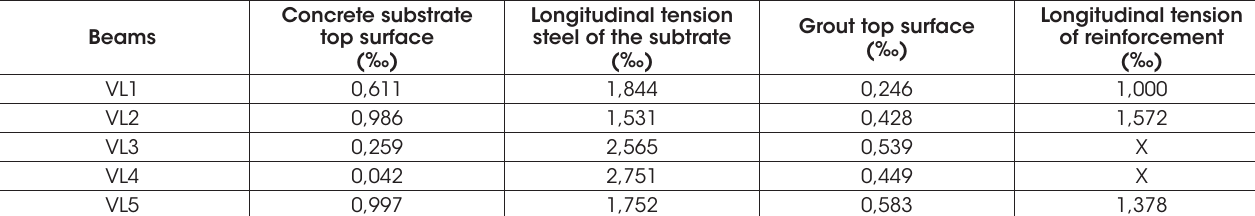
Strains of the constituent elements of the beams at the moment of failure Beams